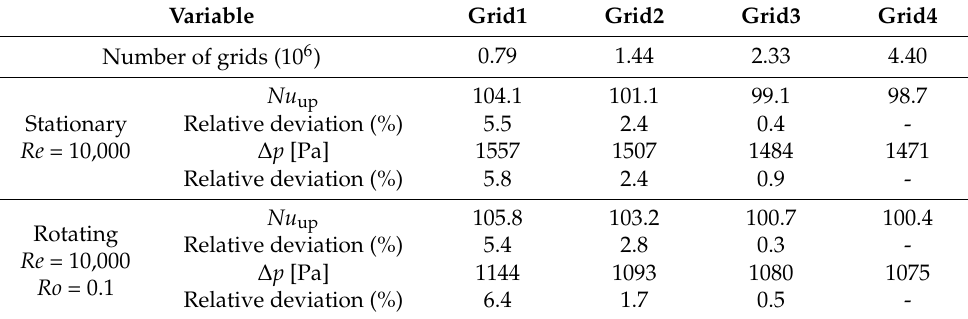
Table 4. The mesh independence verification based on case4 model.